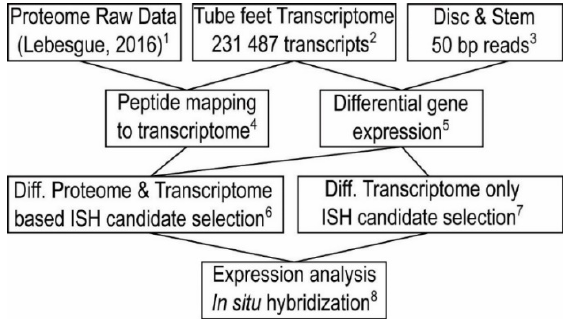
Figure 2. Summary diagram of the integrative transcriptomic and proteomic analysis of the present study . 1 Raw data of Lebesgue et al., containing 10 P. lividus disc-, eight stem- and three adhesive secretion samples, were used for the present study. 2 P. lividus tube feet transcriptome was generated. 3 Disc and Stem specific differential RNAseq reads were generated. 4 Re-mapping of the Lebesgue et al. proteome data to the new P. lividus transcriptome. 5 Identification of adhesive disc specific transcripts using DESeq2 differential gene expression analysis. 6 Selection of candidate transcripts for in situ hybridization (ISH), based on the differential proteome and differential transcriptome. Only transcripts present in both datasets were considered for the ISH screen. 7 In order to ensure an encompassing dataset of disc-specific transcripts, a selection of differentially expressed transcripts, not present in the proteome (due to e.g., insolubility or post-translational modifications), was included. 8 ISH screen of the 59 selected disc-specific transcripts.